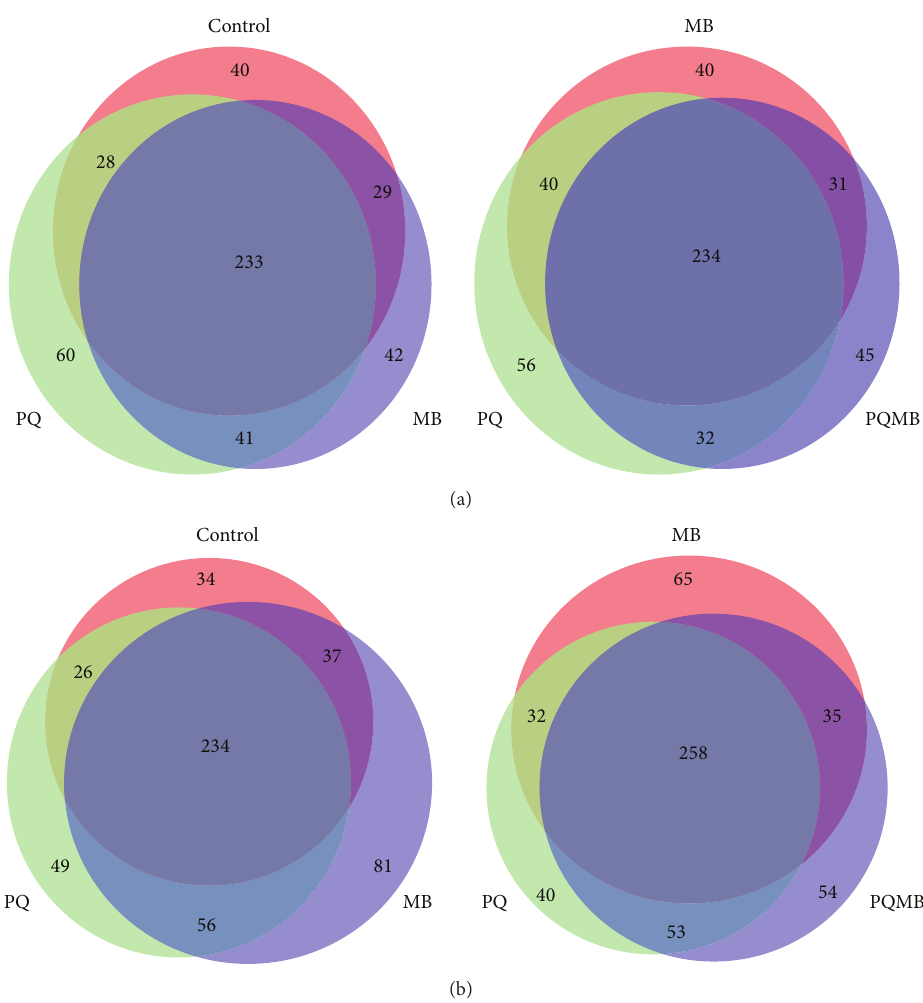
Figure 4: Proteins detected in each brain region display toxicant specific effects. Venn diagrams display the number of proteins that were identified to be unique or shared by the treatment groups in the striatum (a) and the cortex